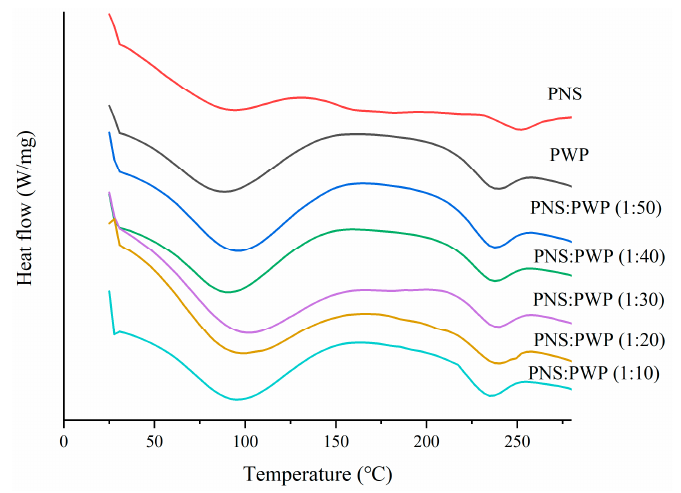
Figure 4. Differential scanning calorimeter (DSC) curves of PWP and PNS-PWP nanoparticles.